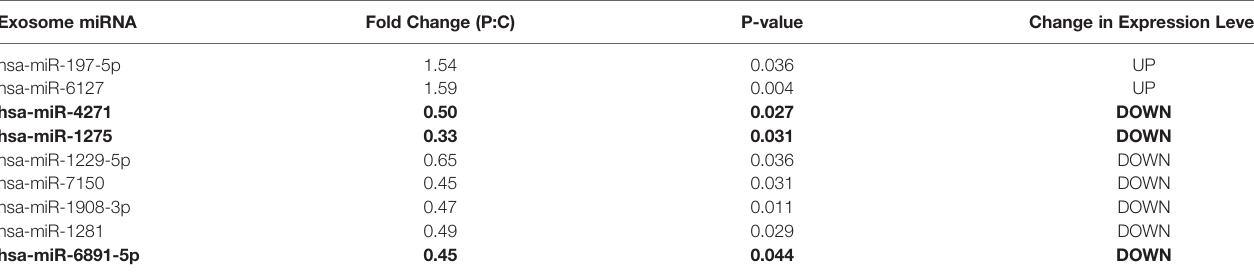
TABLE 3 | Differentially expressed serum exosome miRNAs among pregnant women with ICP and healthy pregnant women. Exosome miRNA Fold Change (P:C)